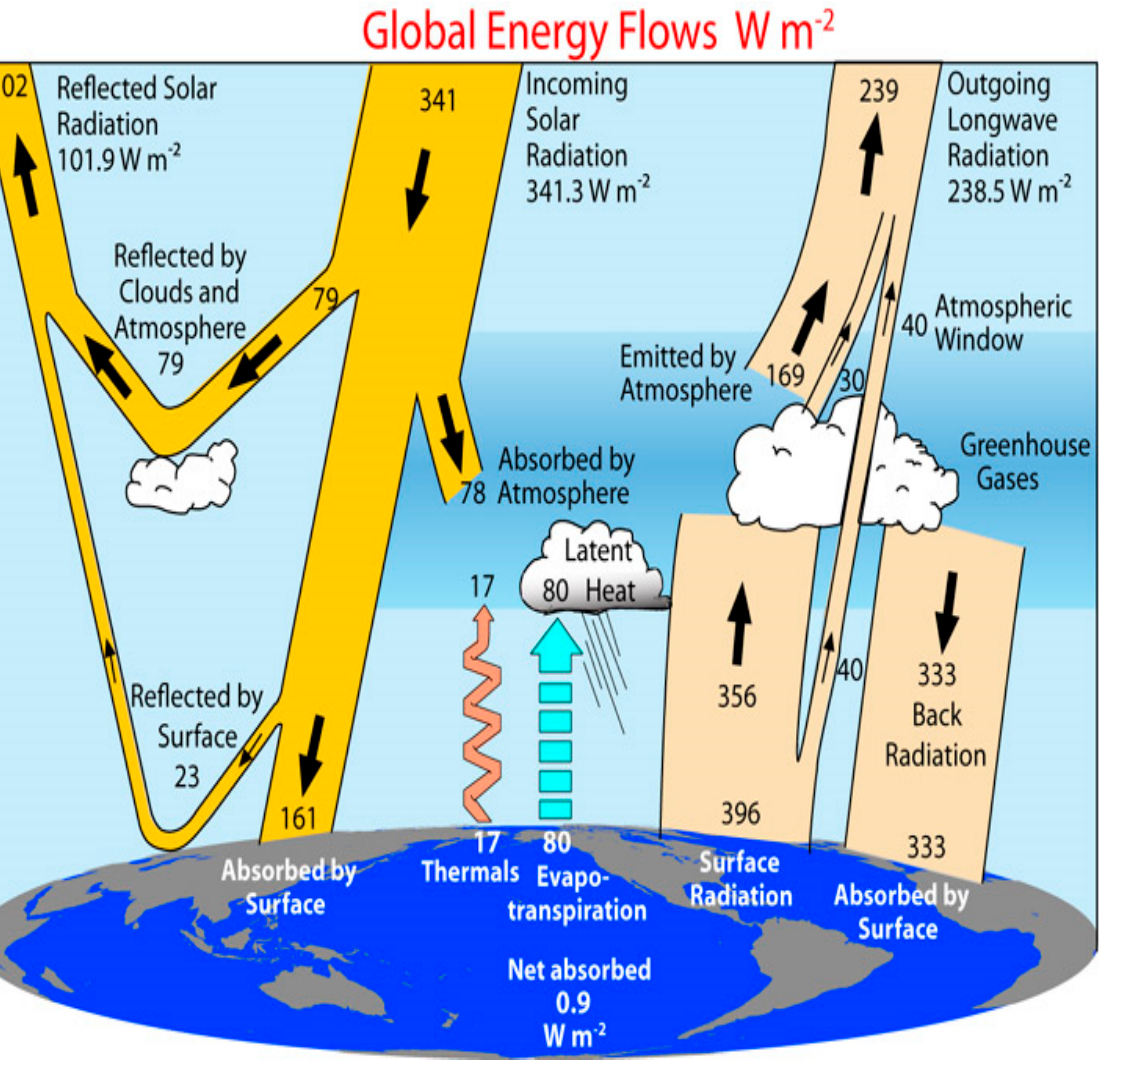
Figure A1. Global Energy Flows.